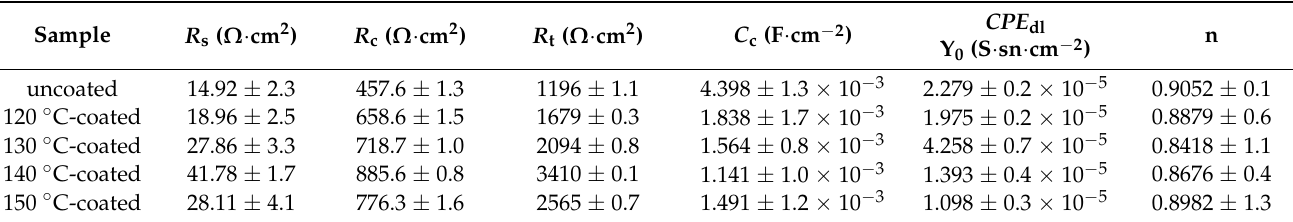
Table 2. Fitted EIS parameters for the substrate and coated samples in NaCl solution based on the equivalent circuit models. Sample